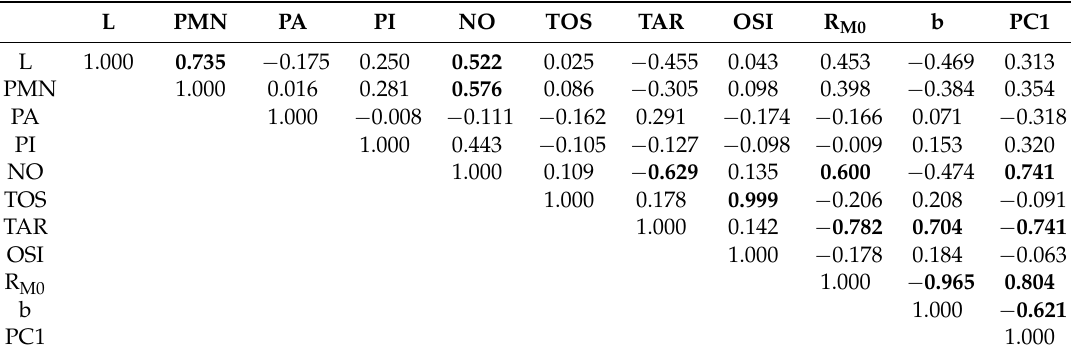
Table 3. Correlation matrix of the lipophilicity indices and antioxidant and anti-inflammatory effects for all the studied compounds. Values greater than 0.5 are in bold face characters.